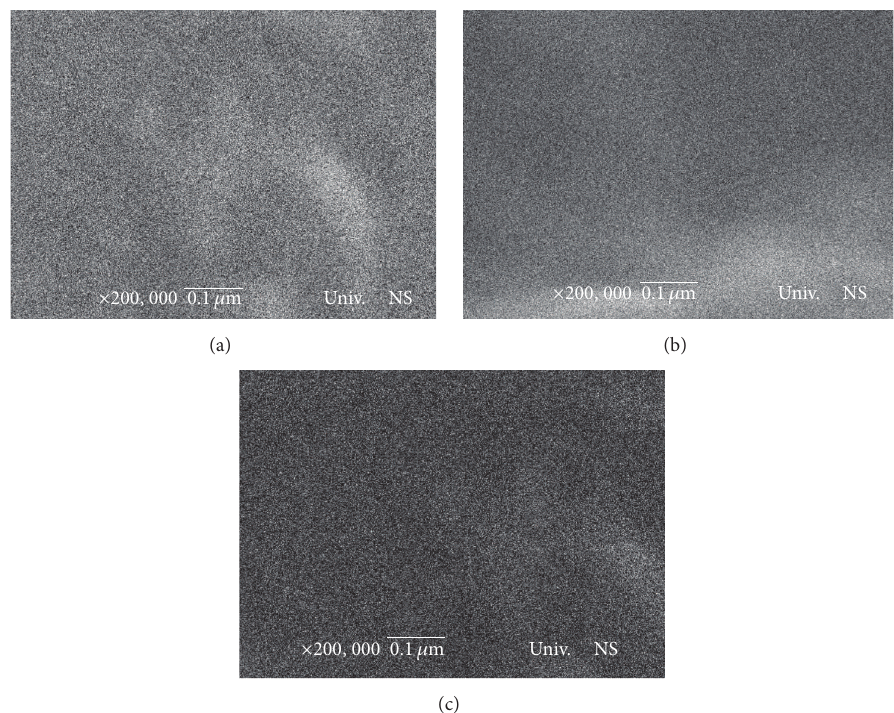
Figure 3: SEM micrographs of (a) sample 1, (b) sample 2, and (c) sample